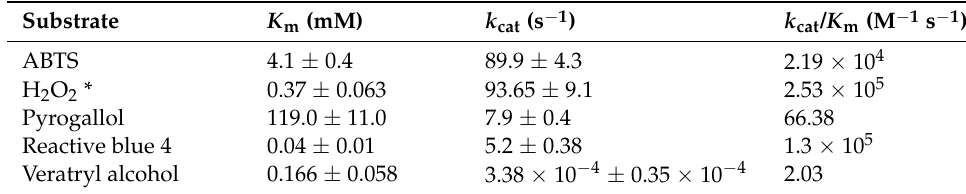
Table 2. Steady-state kinetic data for Dictyostelium